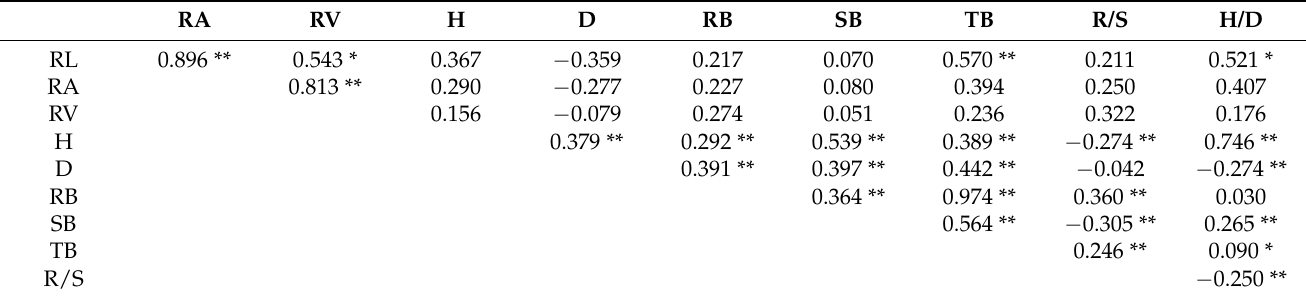
Table 12. Correlation coefficients among seedling traits of X. sorbifolium from four provenances.